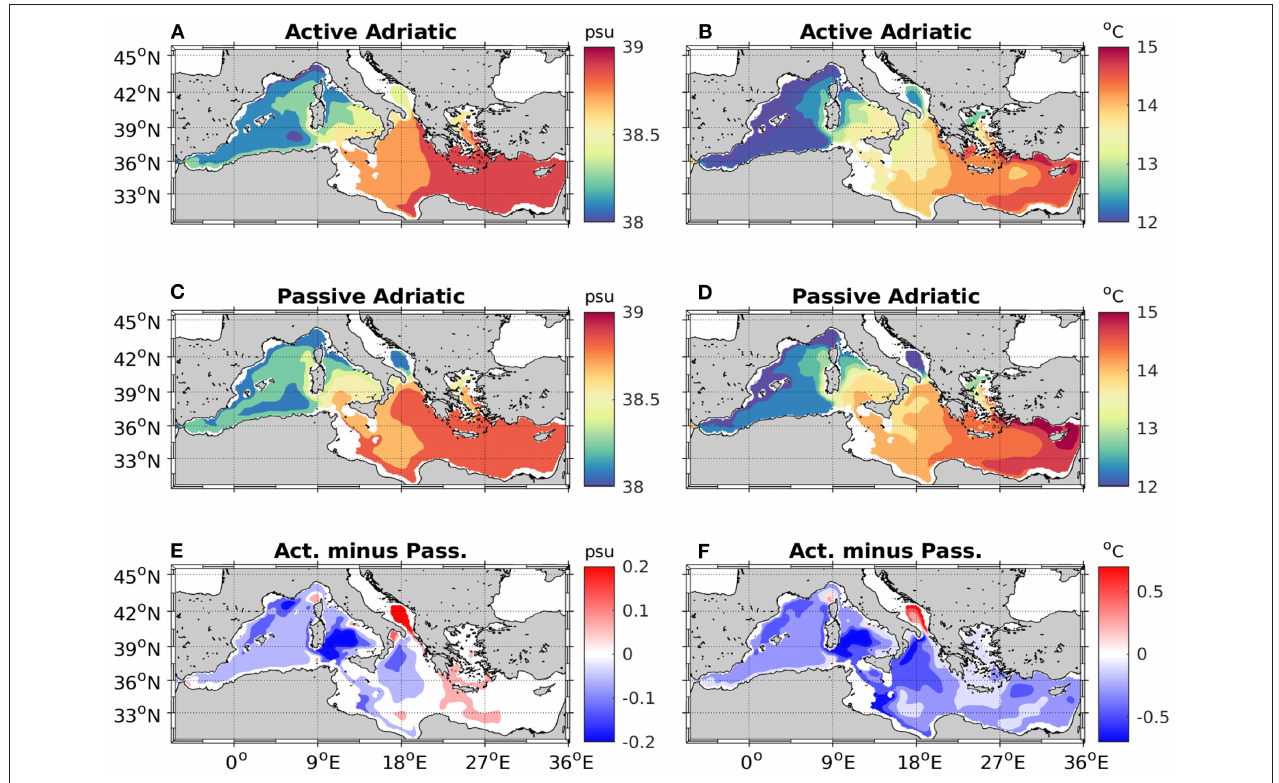
FIGURE 2 | Five-year means of salinity (A,C) and temperature (B,D) at a depth of 250 m from both steady states of active (A,B) and passive (C,D) Adriatic DWF and their difference (E,F)